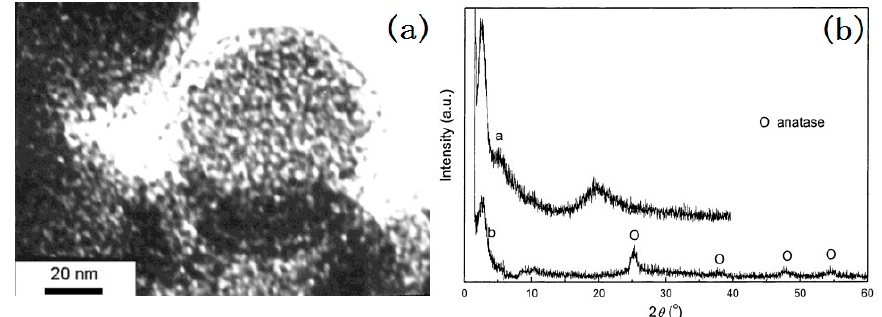
Figure 4. TEM photograph of mesoporous-doped TiO 2 and XRD patterns ( a ) before hydrothermal and acid treatment, ( b ) after hydrothermal and acid treatment of mesoporous-doped TiO 2 [64].